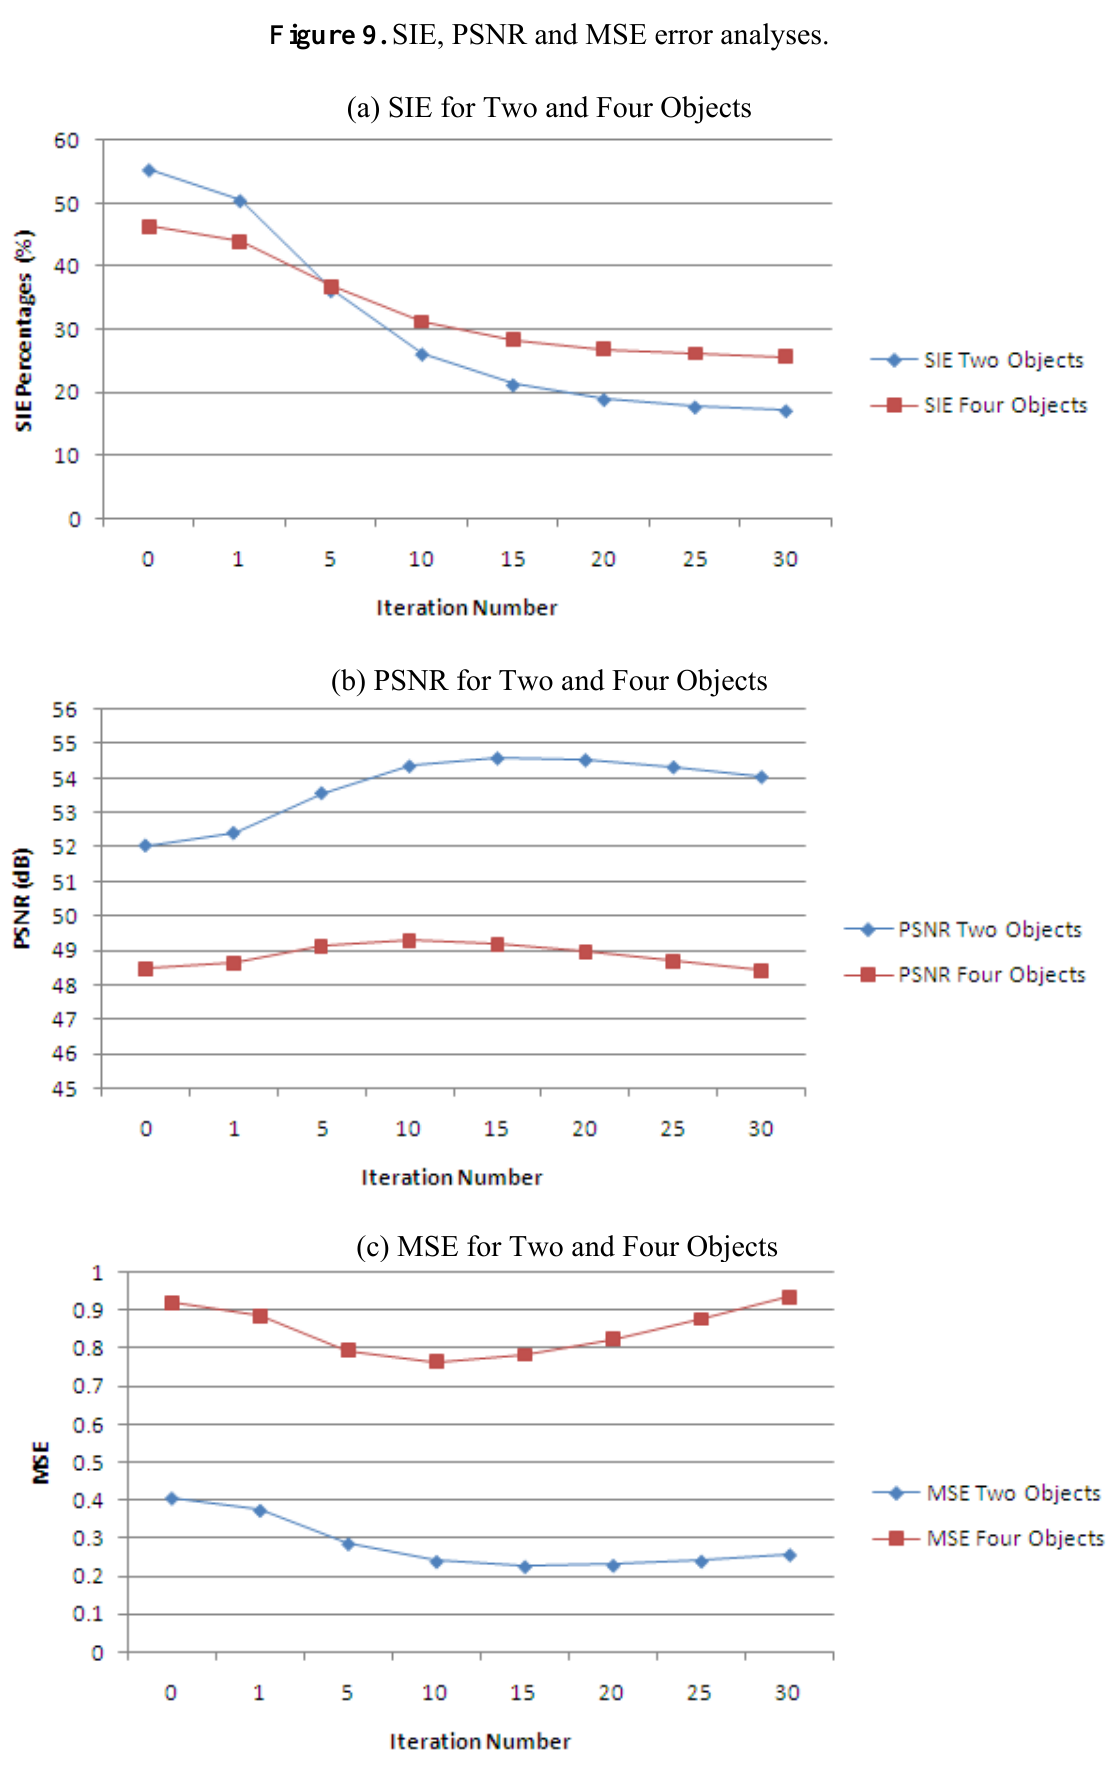
Figure 9. SIE, PSNR and MSE error